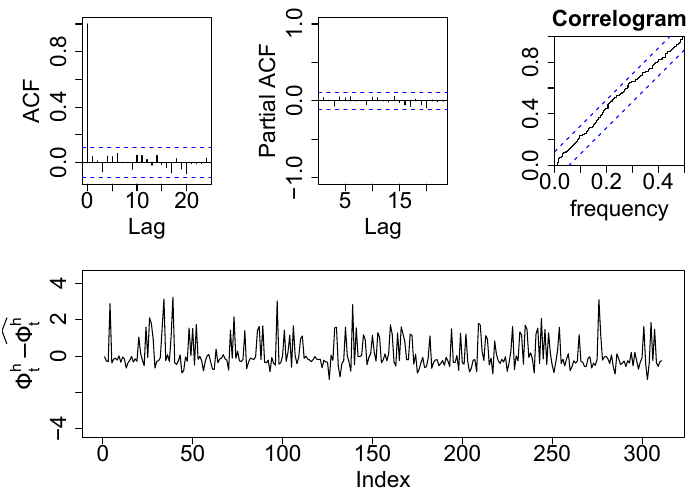
Figure 9. Training residuals of the model with Φ h as output. Once the models of the household are trained and validated, forecasts of the indoor temperature and of the space heating consumption are performed, applying the procedure defined in the Algorithm A1. The prediction period was between 1st March and 31st May. Figure 10 depicts the comparison between measured data of heat consumption Φ h and indoor temperature T i , with the black colored line, and the forecasted ones, ̂ T i , with the red colored line. The set point temperature considered in the